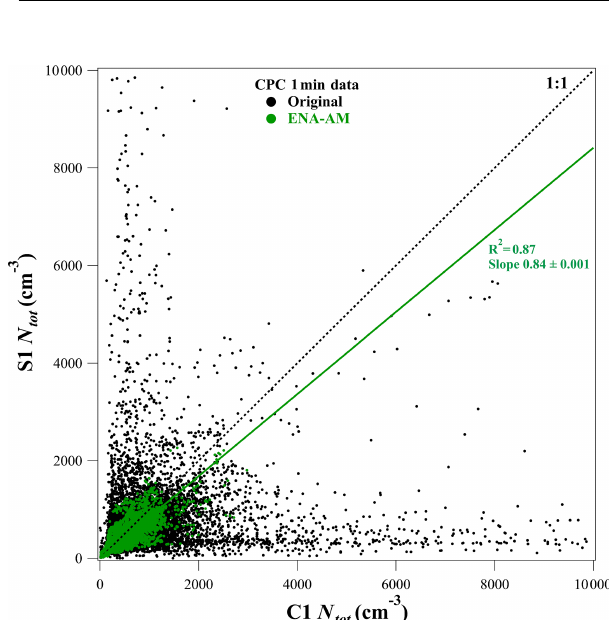
Figure 9. Scatter plot of N tot at C1 and S1 in the summer. Original 1min data (black) are shown with ENA-AM masked data